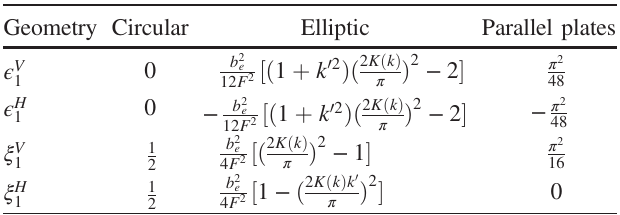
TABLE I. Laslett coefficients for circular, elliptic, and parallel plates geometries